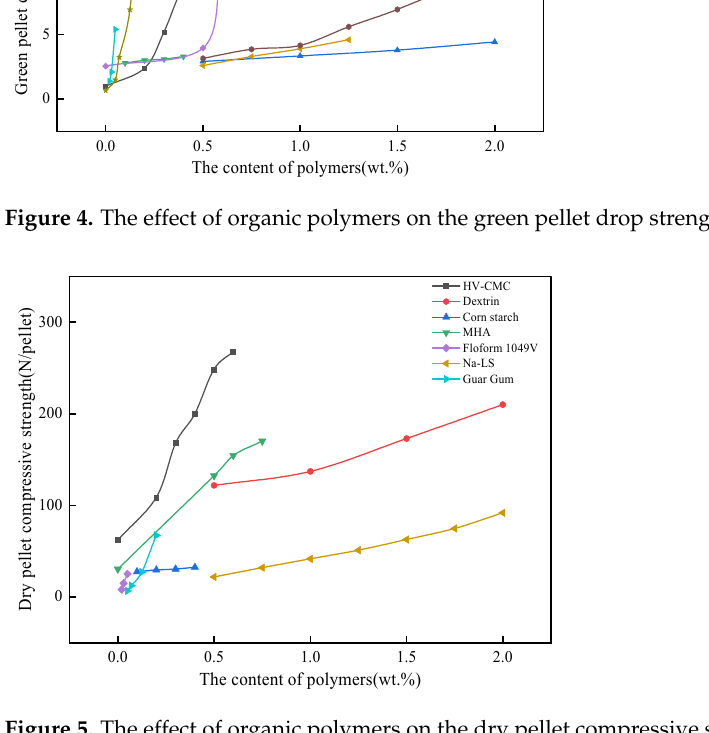
large molecular weights can generate greater chain interactions between them, and these